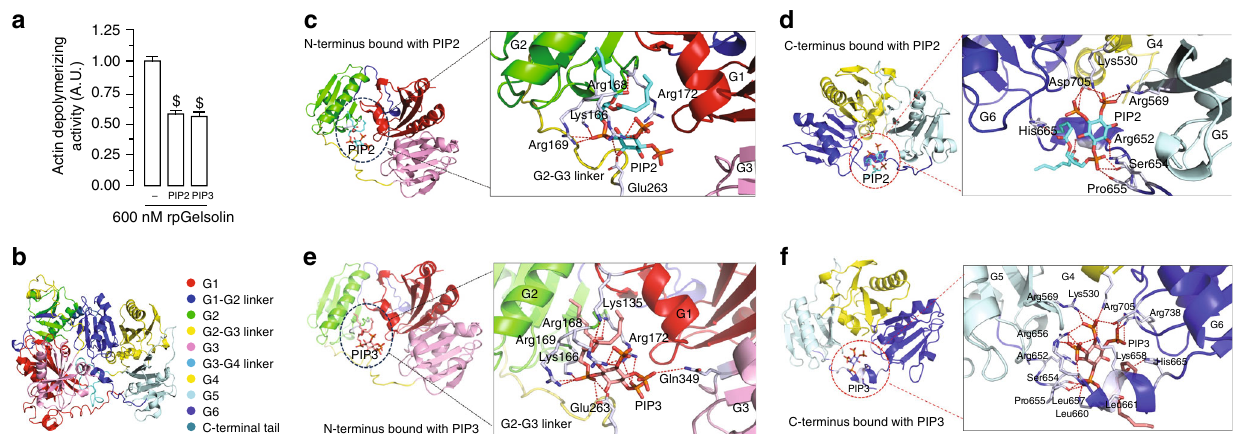
Fig. 3 PIP2 and PIP3 bind with and inhibit gelsolin. a Actin-depolymerization assay showing identical inhibition of gelsolin by equimolar PIP2 and PIP3 in an in vitro lysate-free assay. b Complete model of human gelsolin structure illustrating its 6 domains (G1-G6) and the C-terminal tail. c , d Molecular modeling illustrating potential sites of interaction of the N-terminus ( c ) and C-terminus ( d ) of gelsolin with PIP2. e , f Molecular modeling illustrating potential sites of interaction of the N-terminus ( e ) and C-terminus ( f ) of gelsolin with PIP3. Please also see Supplementary Movies 1 – 4. Data represent means ± s.e.m. $ P < 0.05 compared with the 600 nM rpGelsolin group as determined by one-way ANOVA analysis ( a ). Biological replicates: n = 9 ( a